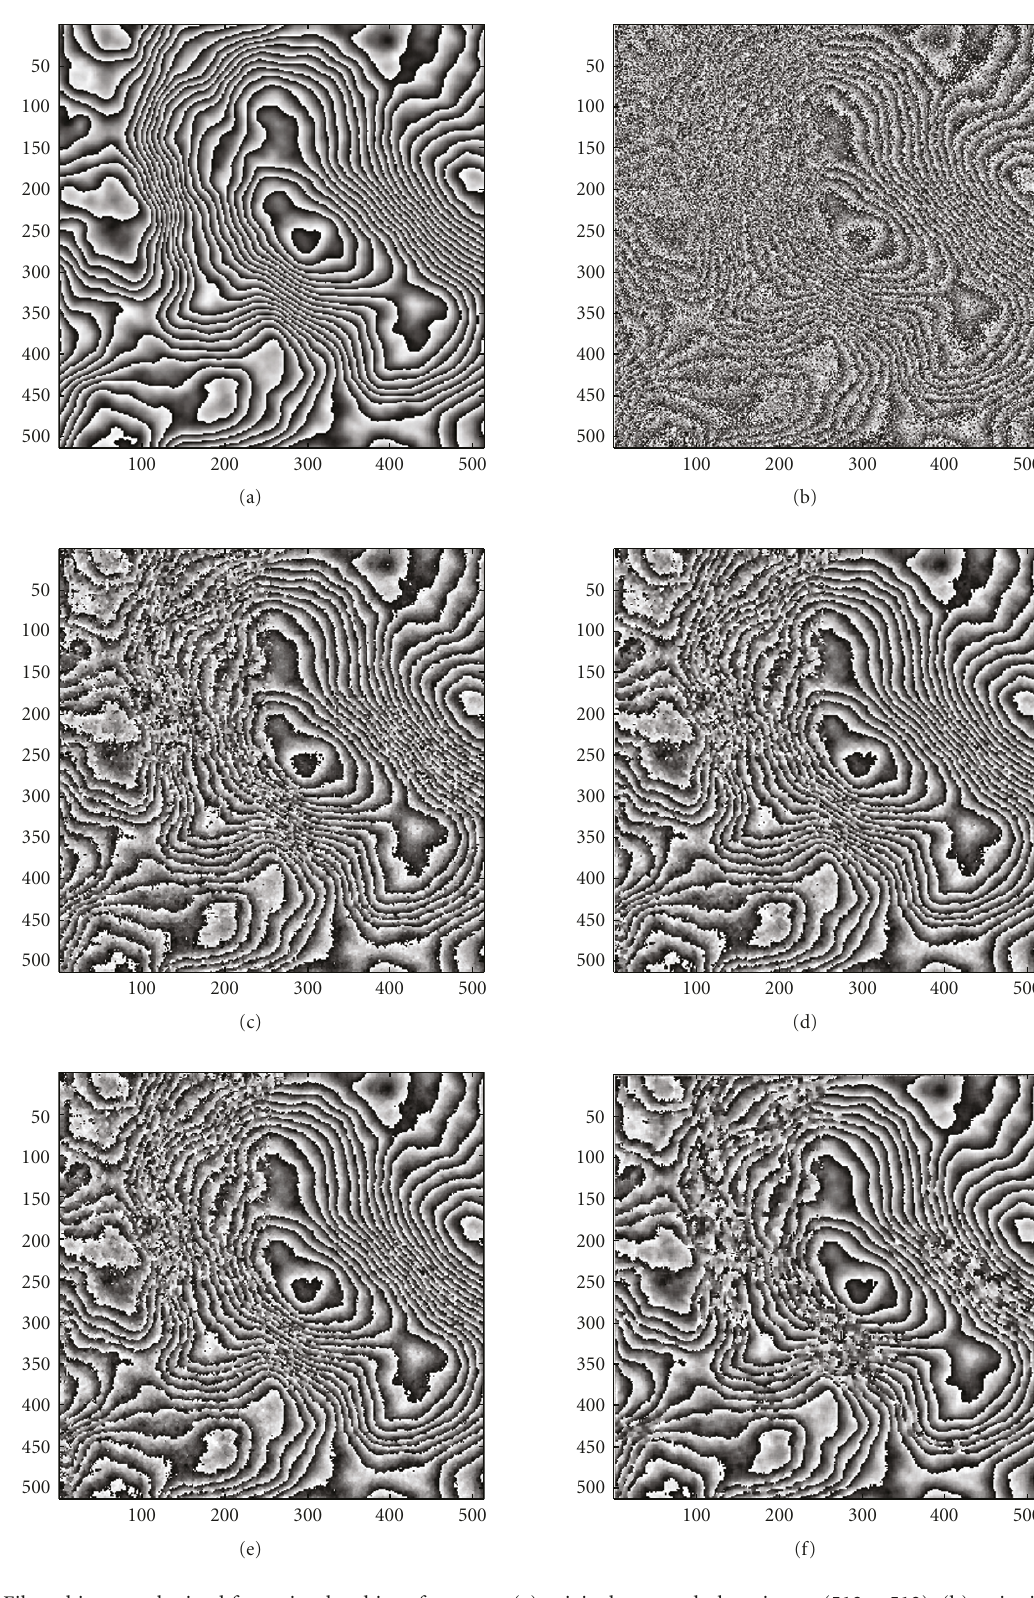
Figure 2: Filtered images obtained from simulated interferogram: (a) original wrapped phase image (512 × 512), (b) noisy interferogram with coherence values 0.2, 0.4, 0.6, and 0.8, counter clockwise from top left quadrant, (c) median filtered image (reference), (d) output of proposed filter, (e) proposed filter using (a) as reference, (f) boxcar filtered